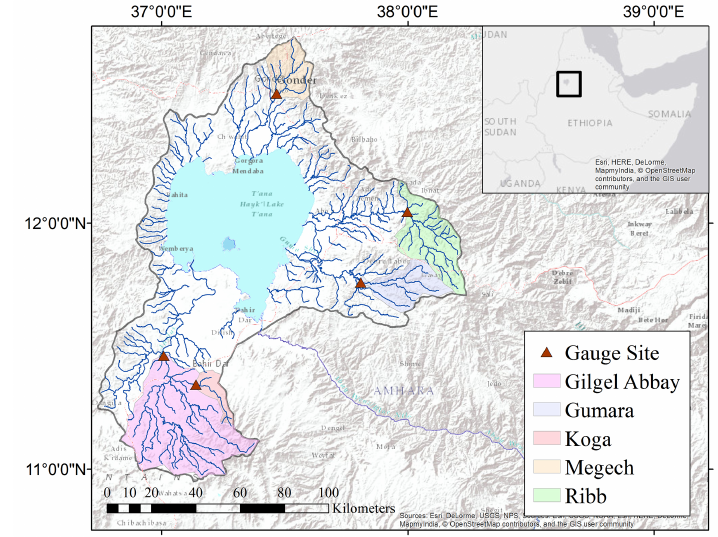
Figure 1. Map of Lake Tana and surrounding